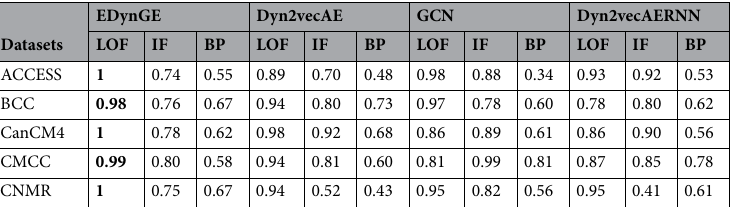
Table 1. Comparison results on synthetic datasets (the bold scores indicate the best performance with the given datasets).